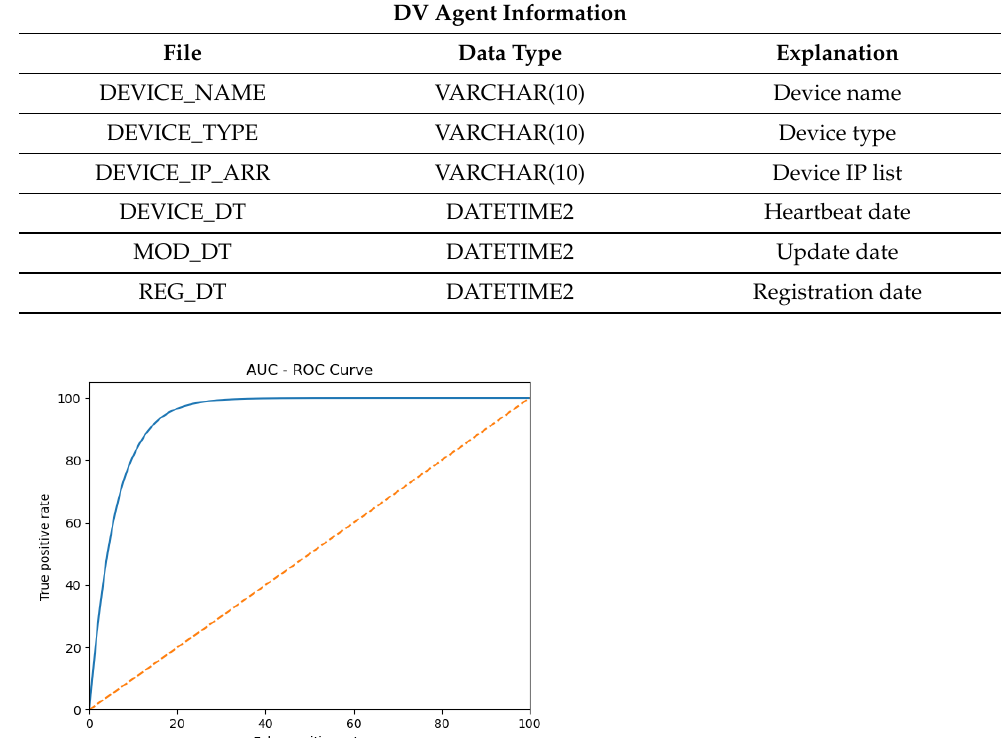
Figure 26. The ROC and AUC values for the results from the two methods (AI and human visual